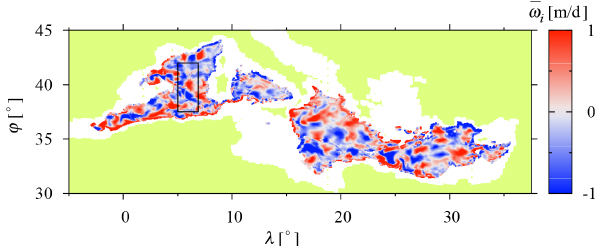
Figure 8. ¯ ω i as estimated from t = 10 . 83d plotted at the initial po- sition of each particle i in the v153 simulation. The black rectangle in the Western Mediterranean is the area of large depth considered in Appendix